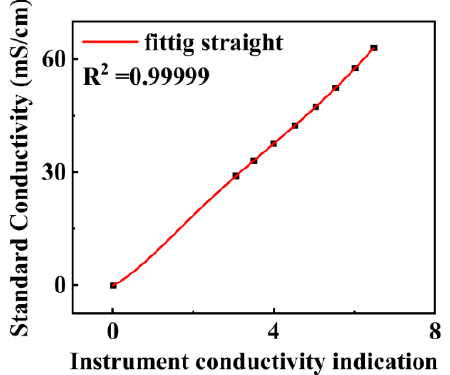
Figure 15. Results of the conductivity calibration experiment.